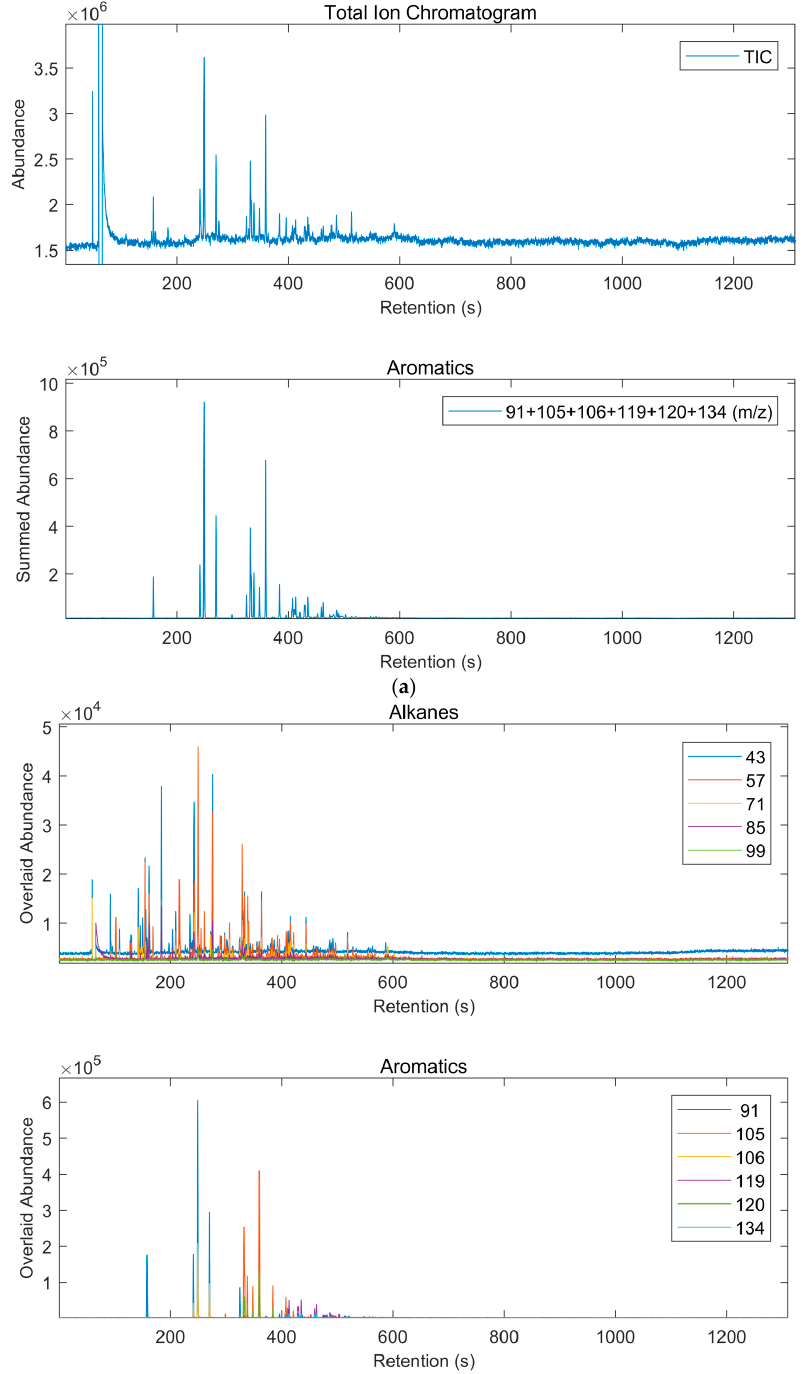
Figure 2. Sample of 1D GC-TOF data for the most abundant gasoline level tested (1.0 μ L/mL) as: ( a ) TIC and summed aromatic EIC; and ( b ) alkane and aromatic EICs displayed as overlays of individual ion chromatograms.